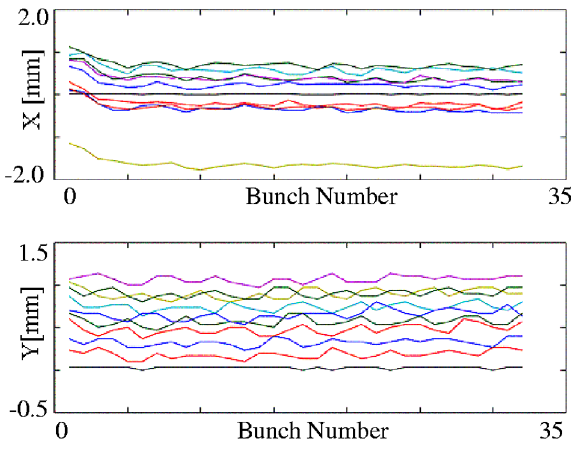
FIG. 9. (Color) BPM signals without the excitation of the deflecting dipole